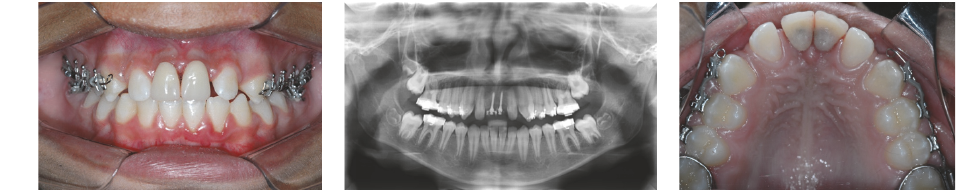
Figure 4: Clinical and radiographic aspects 6 months after mini-implant placement.